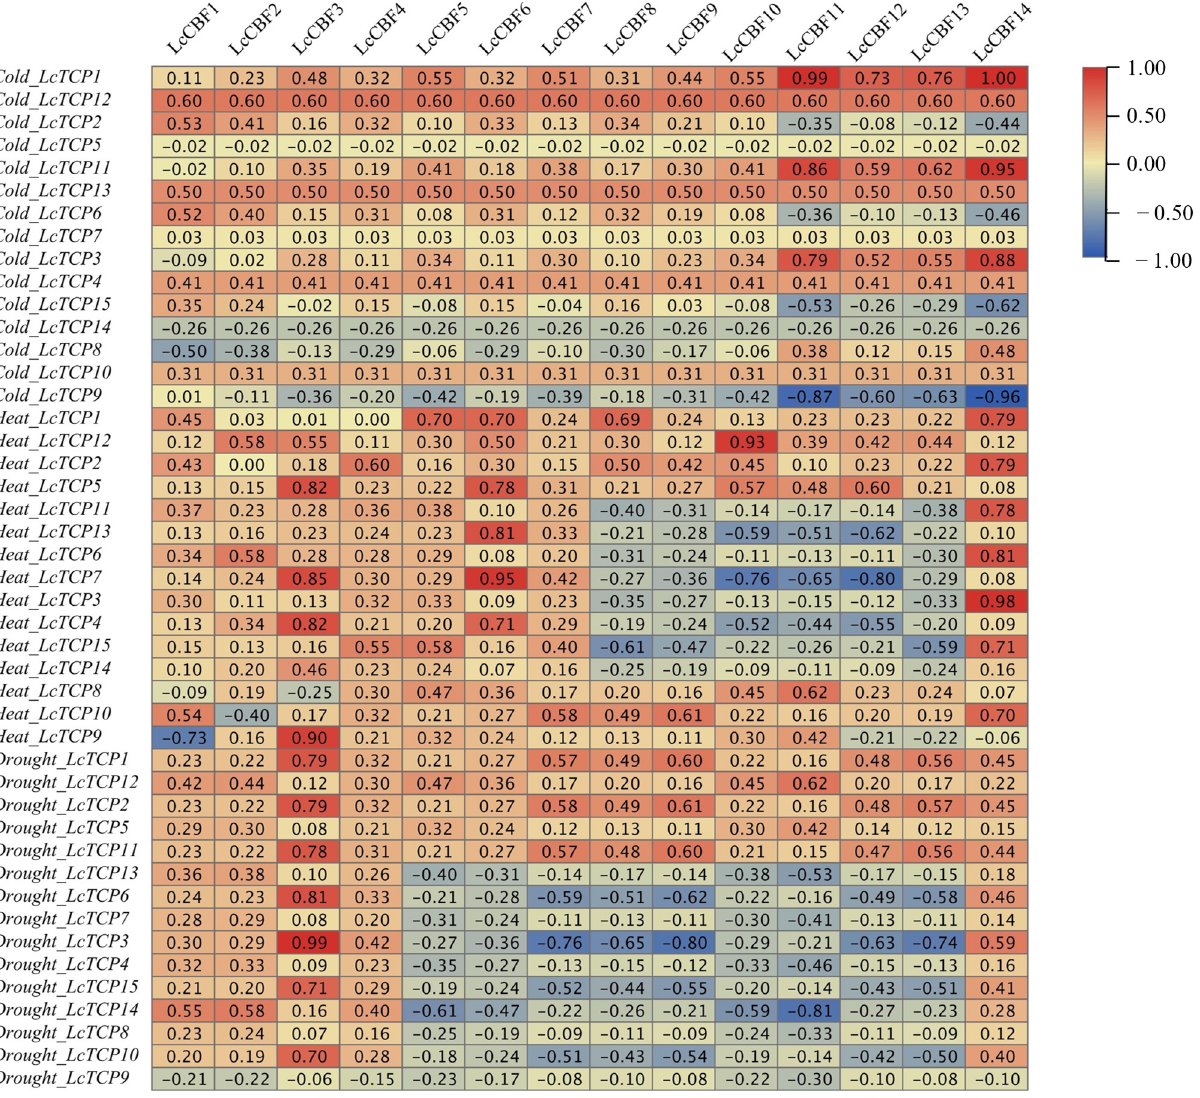
Figure 12. Shows the correlation values of the transcriptomic expression levels between L. chinense TCP genes and L. chinense CBF genes. The LcCBF genes are horizontally depicted at the top, and LcTCP genes are vertically labelled and linked with the corresponding stress treatment. The varying correlation values are presented in Heatmap constructed using TBtools software.